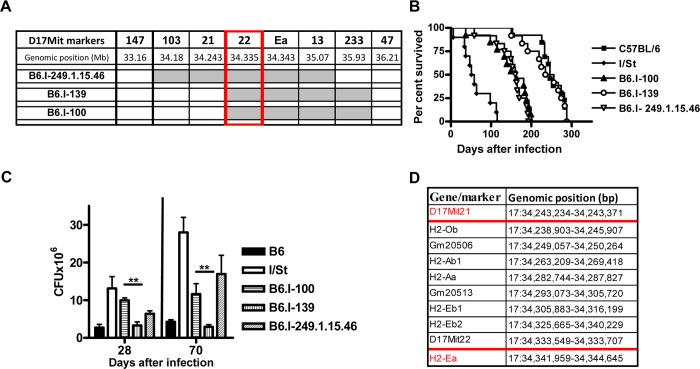
Genotypes and TB phenotypes of new recombinant mouse strains B6.I-100 and B6.I-139.
A–The genome chart for B6.I-100 and B6.I-139 recombinant strains. Chromosome segments transferred from I/St onto B6 genetic background are shown in grey. B–survival curves of B6.I-100, B6.I-139 and parental strains mice after aerosol challenge with ~500 CFU of M. tuberculosis. MST ± SEM (days): B6 = 249 ± 10; I/St = 63 ± 11; B6.I-100 = 152 ± 13; B6.I-139 = 233 ± 14; B6.I-249.1.15.46 = 153 ± 11. Recombinant strains were tested in 3–5 independent experiments (total N = 20–40 males). Summary of 3 experiments is displayed (Kaplan-Meier survival analysis). C–CFU counts in infected lungs at days 28 and 70 post-challenge (4 mice per group, **P < 0.05, ANOVA). The representative results of one out of 2 independent experiments are present. D–genes and their positions in the D17Mit21 – H2-Ea interval according to Ensembl. Red borders–location of the candidate gene.